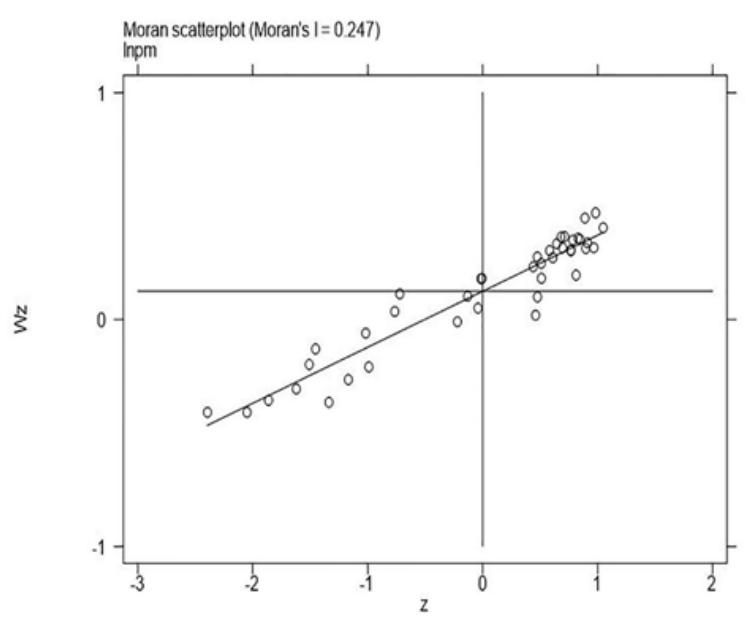
Figure 2. Moran’s I scatterplot of PM2.5 concentration in